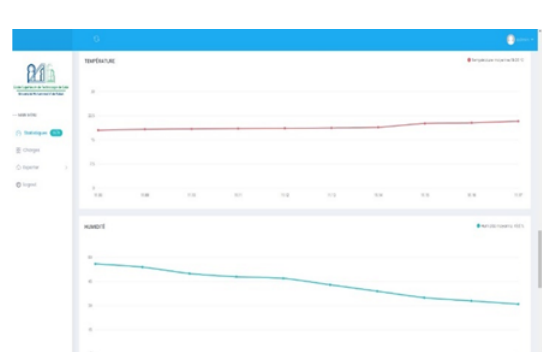
Fig. 7: Temperature and humidity curves